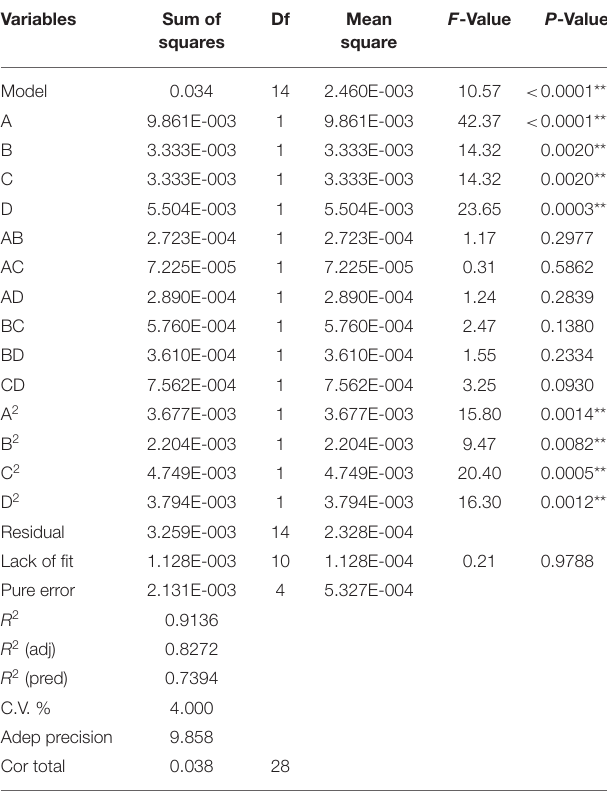
TABLE 2 | Extraction yields of SEOs with different extraction conditions by RSM. Run Liquid-solid Ultrasonic Distillation NaCl Extraction